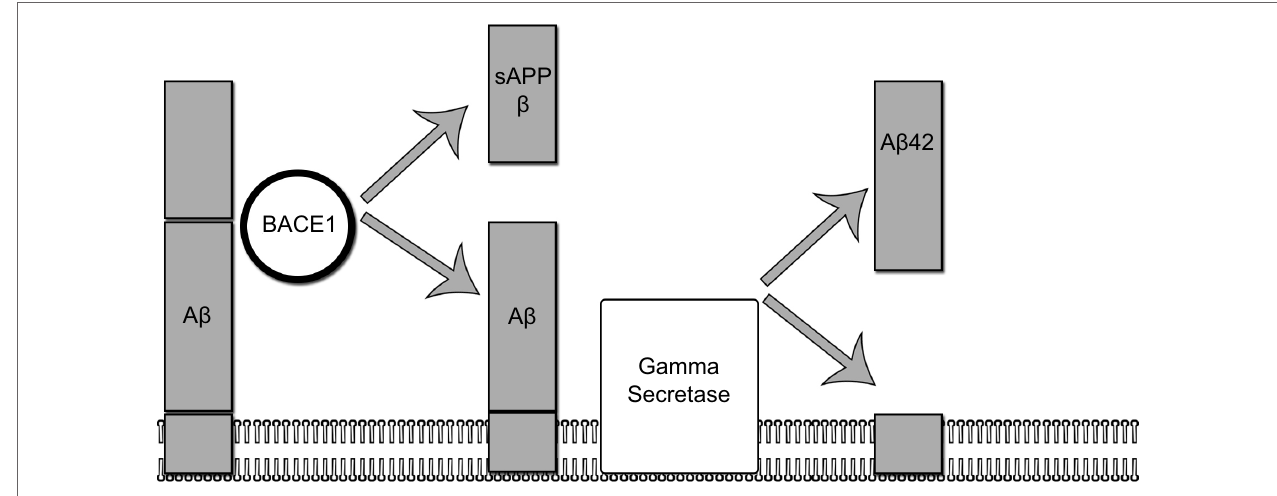
fragment and releasing sAPP into the interstitial space. (2) In the second step, gamma secretase cleaves the remaining membrane-bound fragment releasing an abeta 42